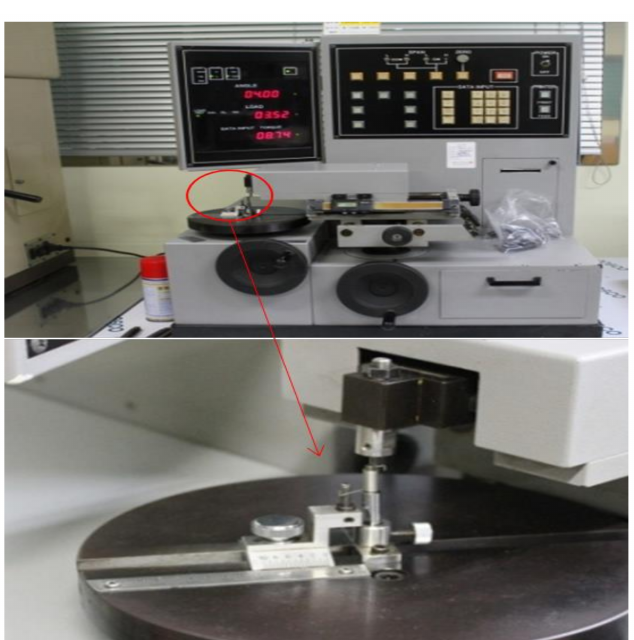
Figure 8. A sensor-based machine measuring the actuating force of a